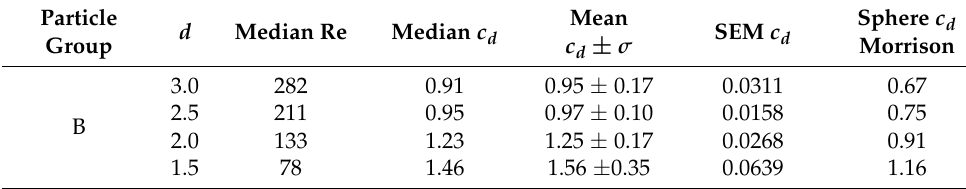
Table 3. Experimental data for particle group B.